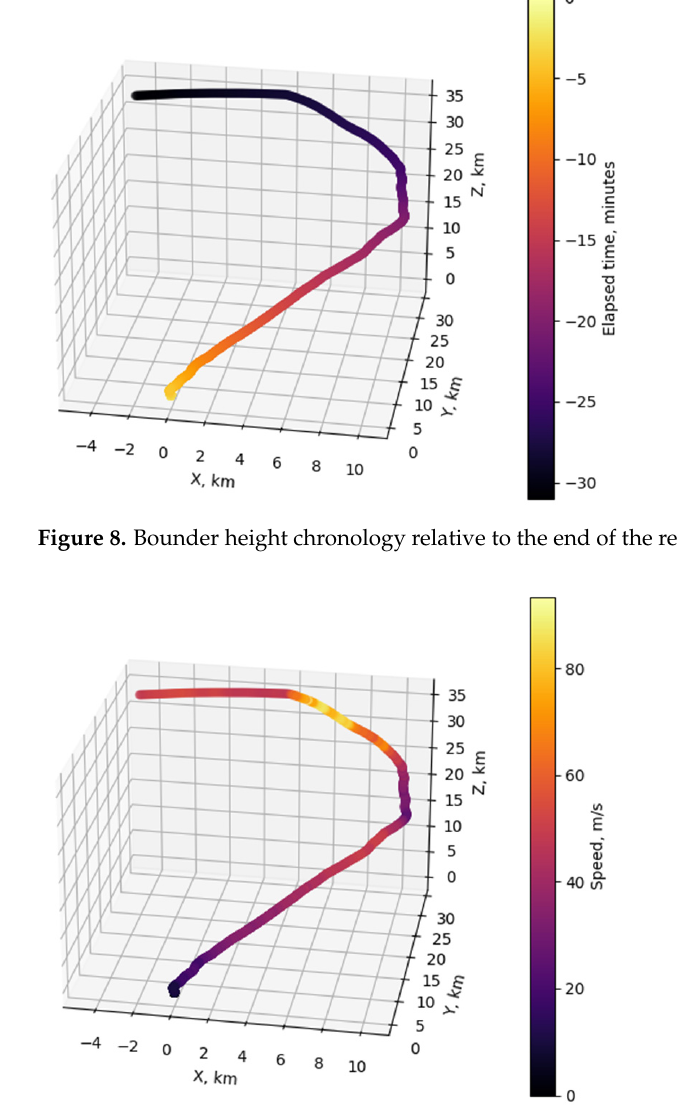
Figure 9. Bounder speed estimated from position.